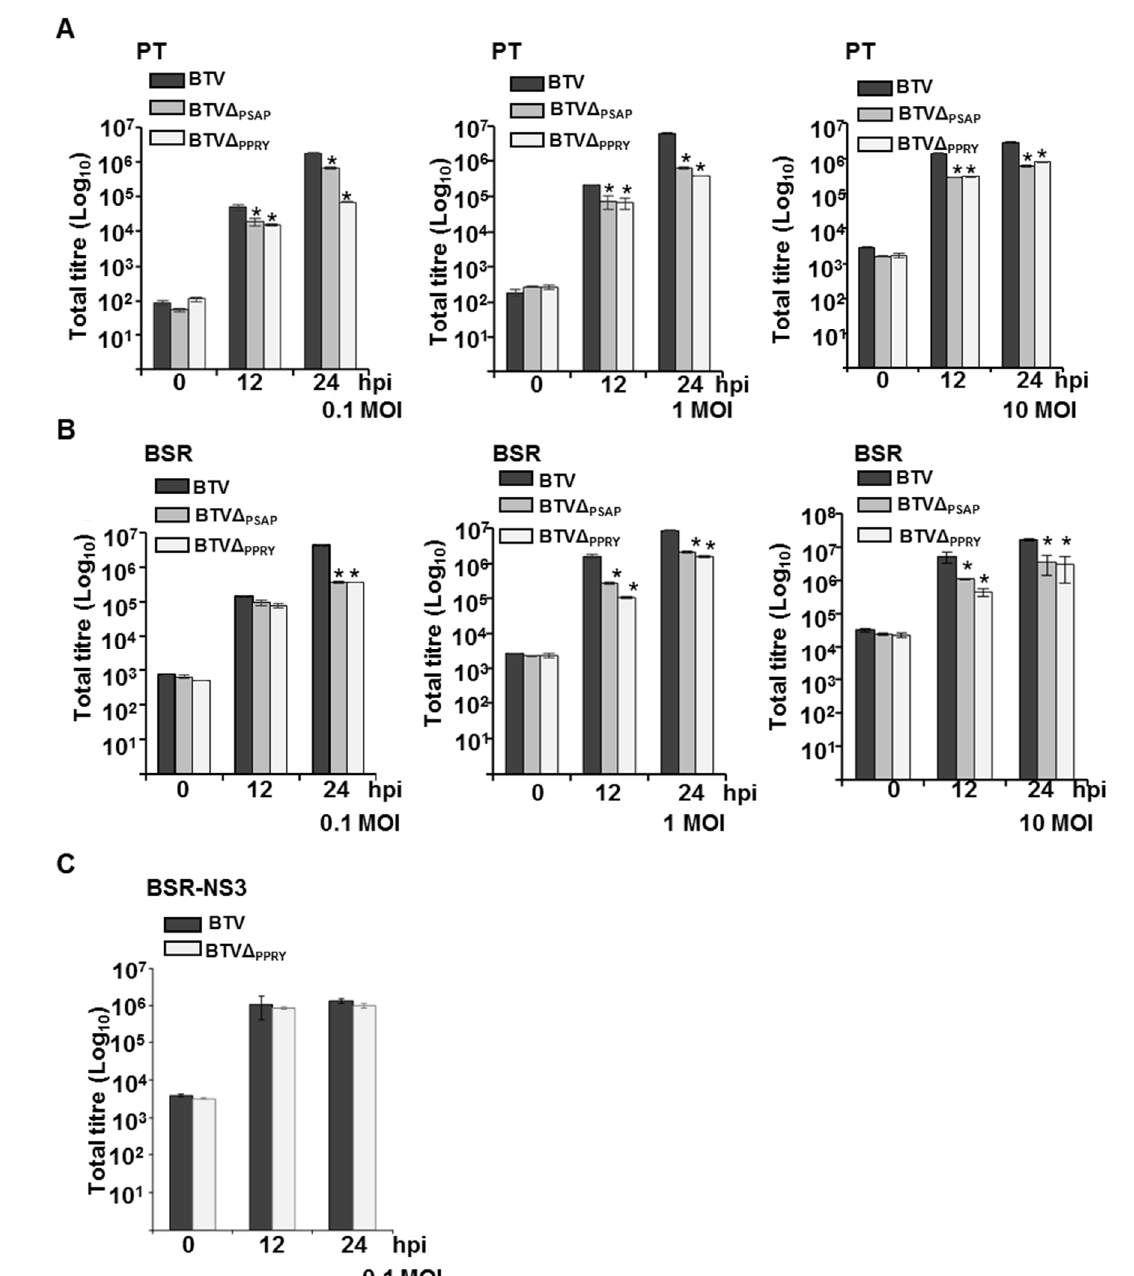
Figure 6. Characterization of BTV Δ and BTV Δ . Total titres at different times pi of PPRY PTAP either BTV Δ BTV Δ or BTV in PT ( A ); BSR ( B ) and BSR-NS3 ( C ) cells PPRY , PSAP